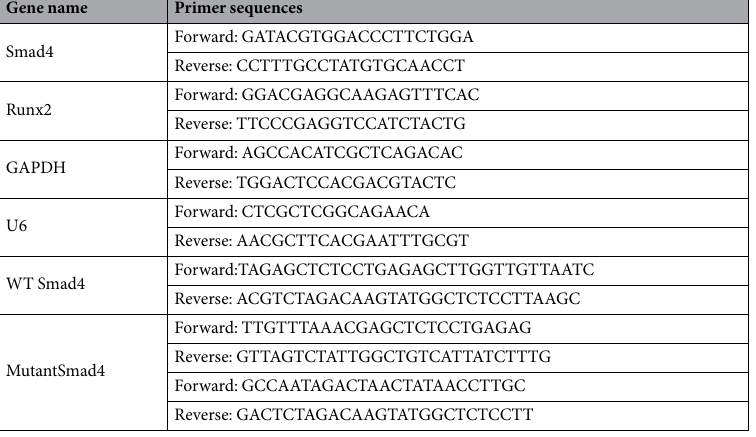
Table 2. Primers used in the